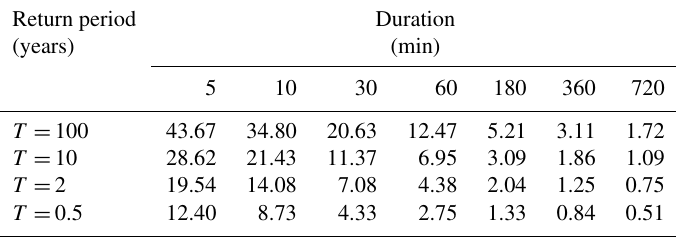
Table 2. IDF intensities (µms − 1 ) for various return periods for Denmark extracted from the model presented by Madsen et al. (2017).